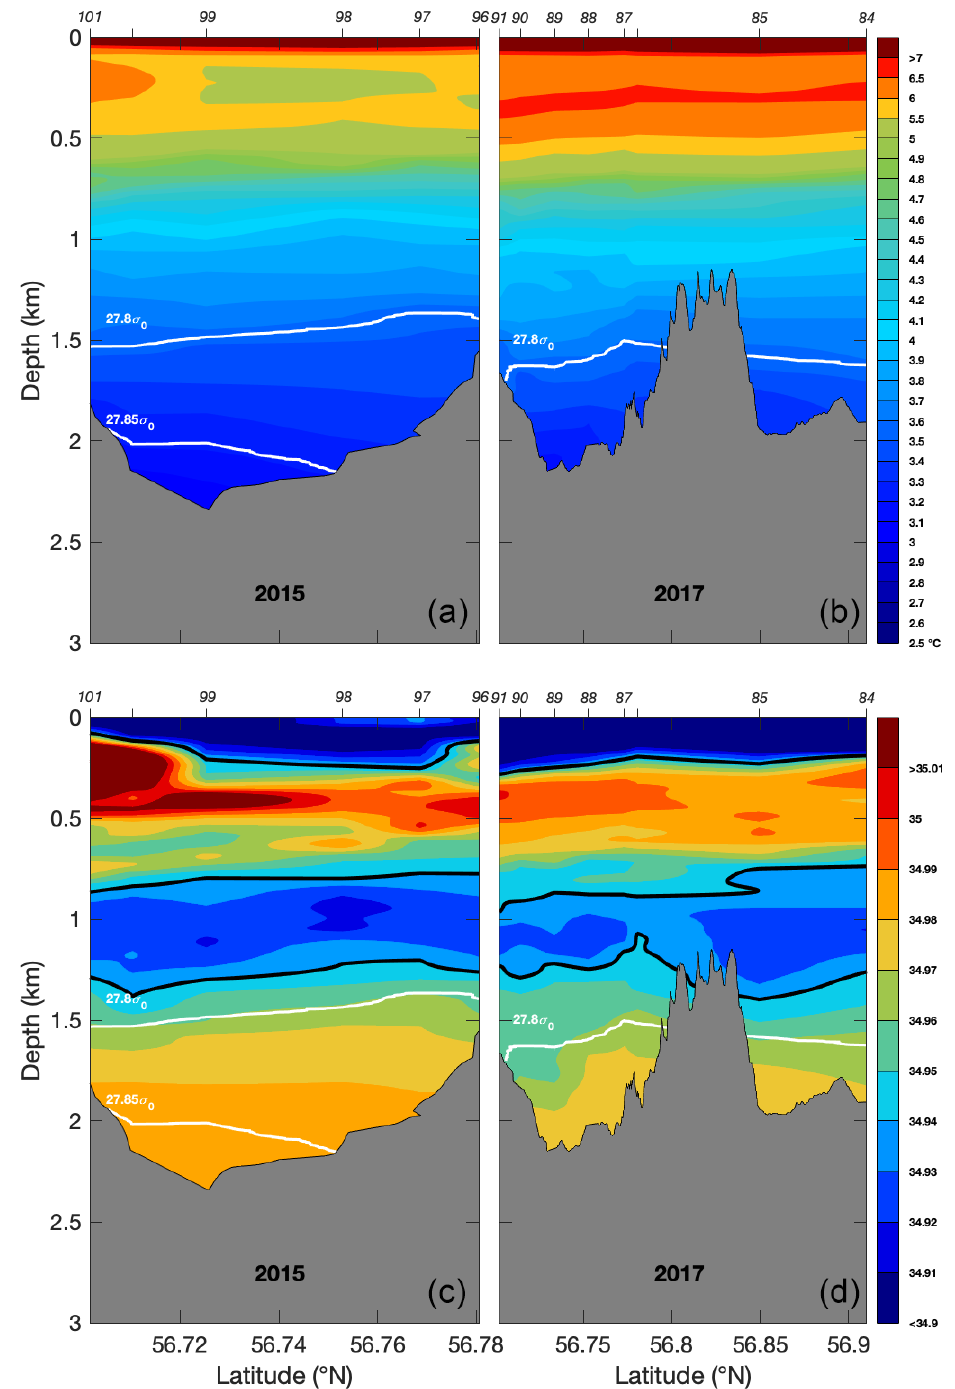
Figure A1. Hydrographic sections along the East sections in 2015 and 2017 based on CTDO2 data for (a, b) potential temperature in degrees Celsius and (c, d) salinity. The bold black lines represent isohaline 34.94 for the lower panels. In all panels, the bold white lines show the potential density anomalies σ 0 = 27 . 52, 27.71, 27.8 and 27.85kgm − 3 . Bathymetries in gray are from the ship surveys. Locations and numbers of the hydrographic stations are indicated on the top